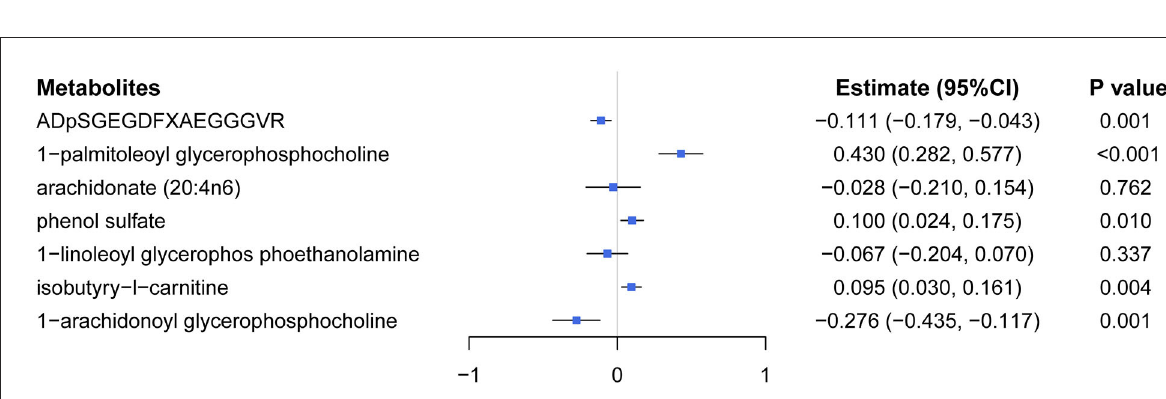
FIGURE5 Effects of five significant causal metabolites on eBMD were estimated by using the multivariate MR regression.